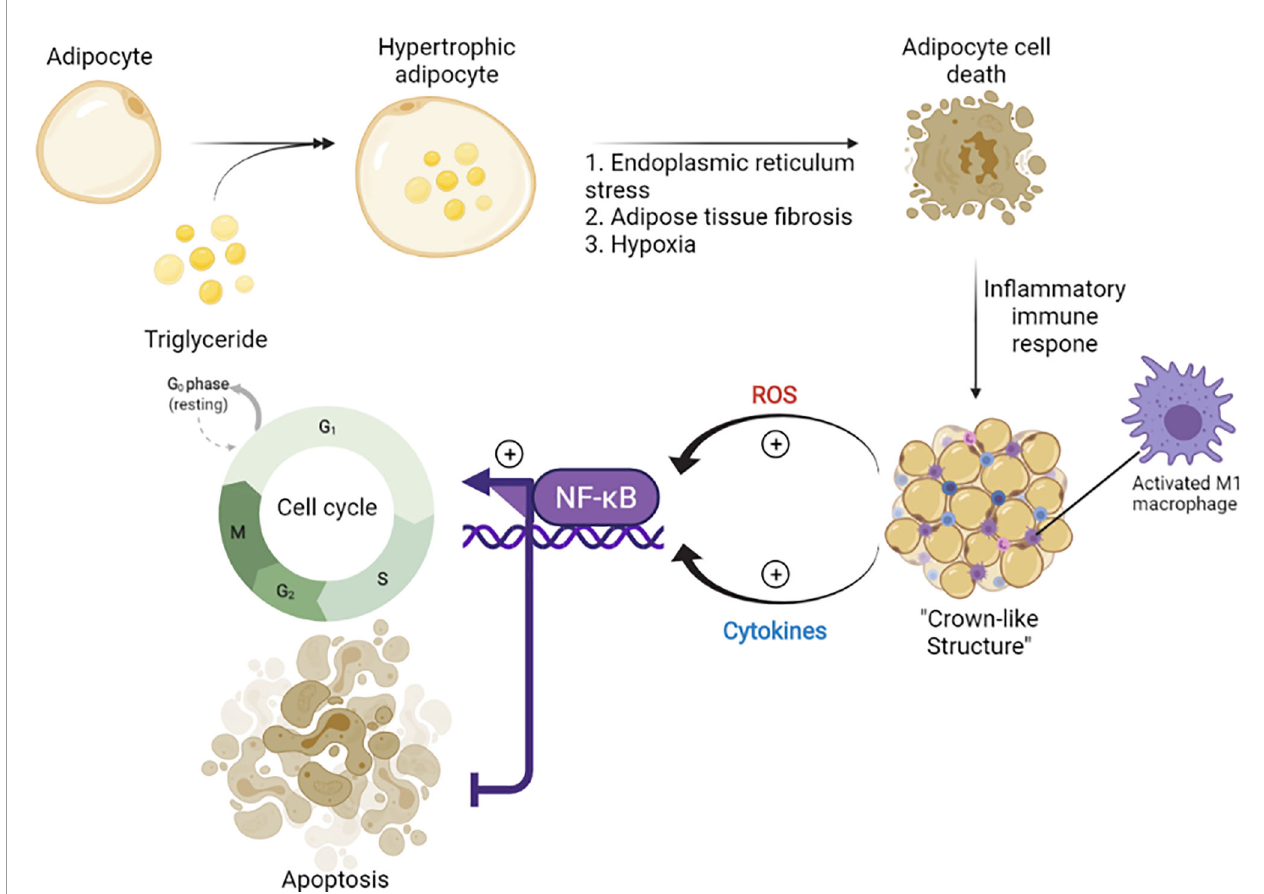
FIGURE 1 | The role of obesity in the stimulation of carcinogenesis (71). Chronic low level of in fl ammation was reported in obese individuals and associated with the in fl ammatory immune responses initiated by the death of adipocytes. During this process, M1 macrophages are accumulated and form a crown-like structure, which provokes cell cycle progression in adipose stromal cells of the breast via secretion of in fl ammatory mediators (TNF- a , IL-6, IL-11) and activation of NF- k B. tumor necrosis factor-alpha, TNF-a; interleukin 6, IL-6; interleukin 11, IL-11; nuclear factor kappa-light-chain-enhancer of activated B cells,